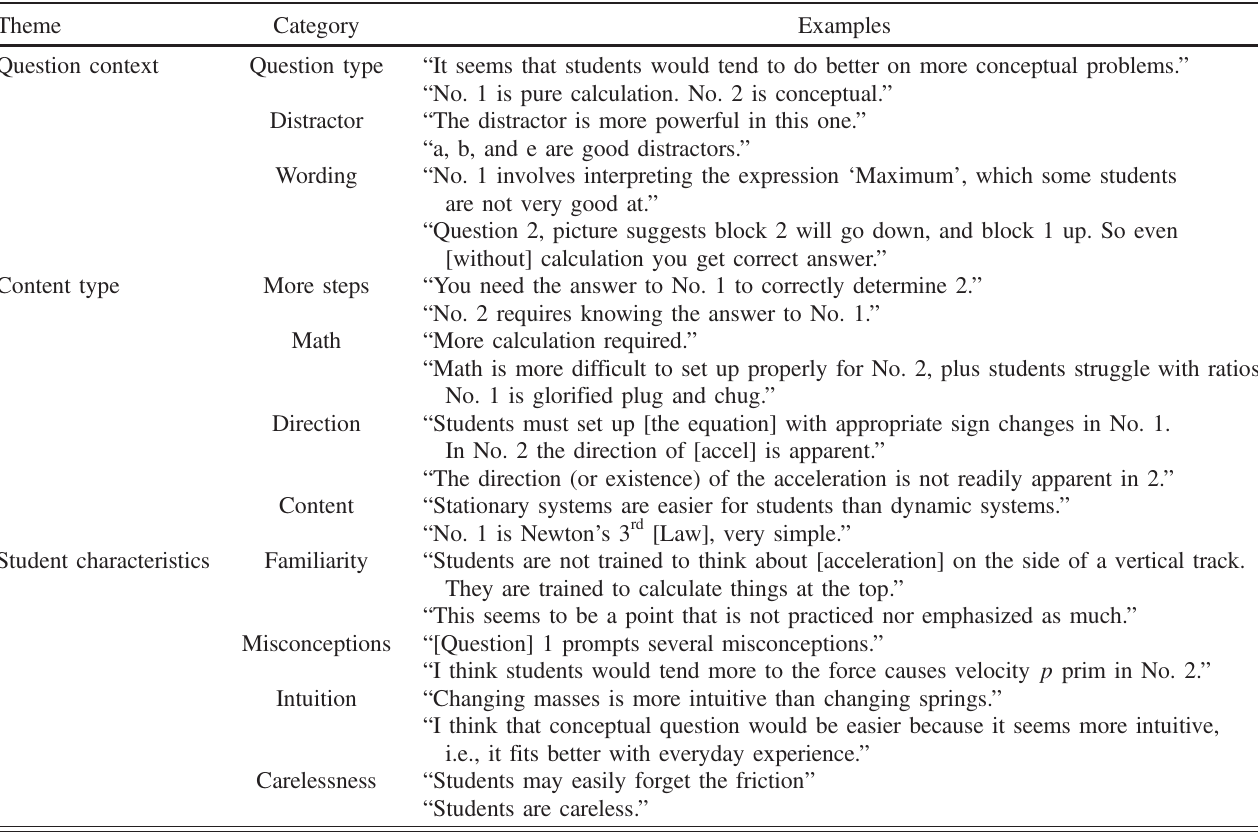
TABLE I. PER expert rationale category